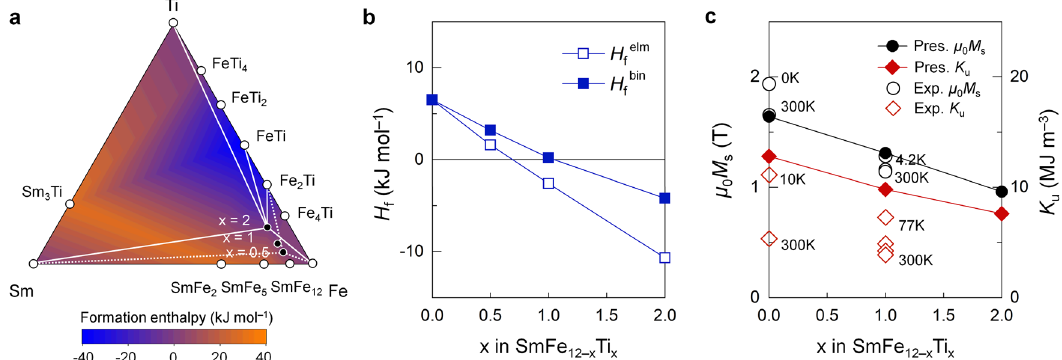
Fig. 2 Structural stability and intrinsic magnetic properties of Sm − Fe − Ti system. a Heat map of the formation enthalpy of the ternary Sm − Fe − Ti system. Open nodes mark the known elemental and binary phases. Solid nodes represent the present ternary SmFe 12 − x M x (x = 0.5, 1, and 2) phases. Dotted and solid lines are the projections of the convex hull construction into compositional space. b Formation enthalpy H f and c saturation magnetization μ 0 M s (left) and uniaxial magnetocrystalline anisotropy K u (right) of SmFe 12 − x M x (x = 0, 0.5, 1, and 2). The corresponding experimental results for SmFe 12 measured at 0 − 300 K 22,23 and SmFe 11 Ti at 4.2 − 300 K 15 – 17 are indicated by the open symbols, where the result at 0 K is determined by fi tting with low-temperature measurements 22